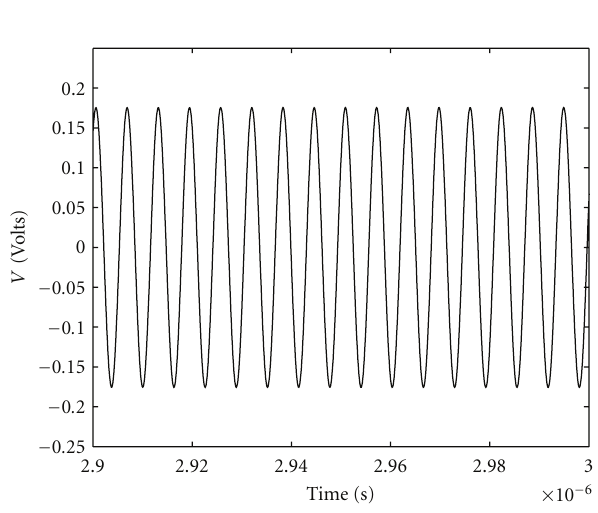
Figure 10: Oscillator circuit used for transient simulation.